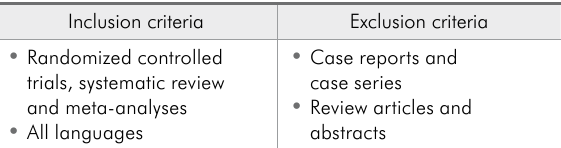
Table 2 - Initial inclusion and exclusion criteria for the stud- ies retrieved.